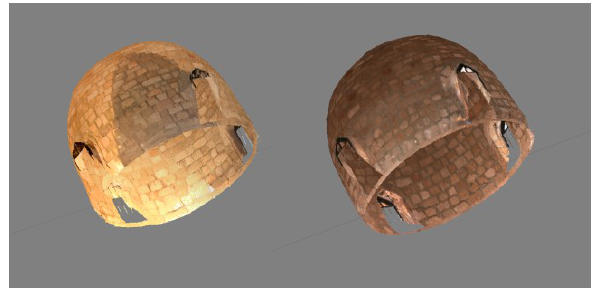
Figure 6. The dome of the church before (left) and after (right) colour calibration.